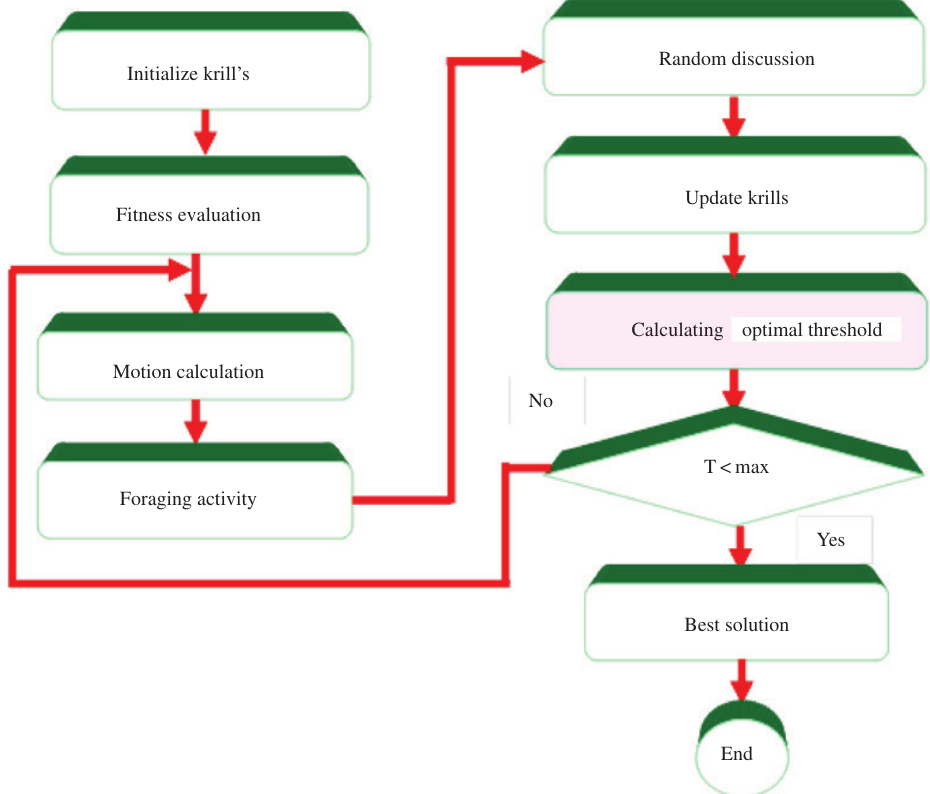
Figure 3: Flow Chart for